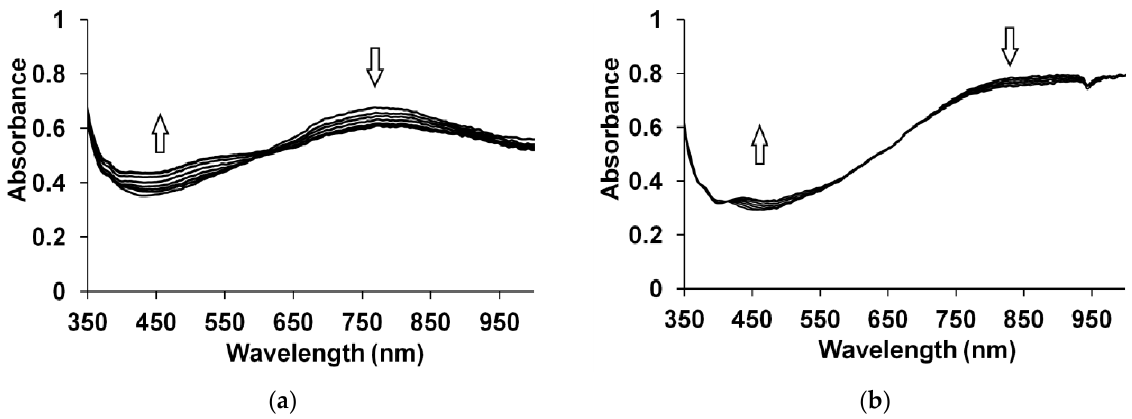
Figure 8. Changes in the optical absorption spectra of ( a ) PEDOT–PAMPSA/t-PASA and ( b ) PEDOT–PAMPSNa/t-PASNa films during exposure to ammonia vapors with the concentration of 25 ppm.